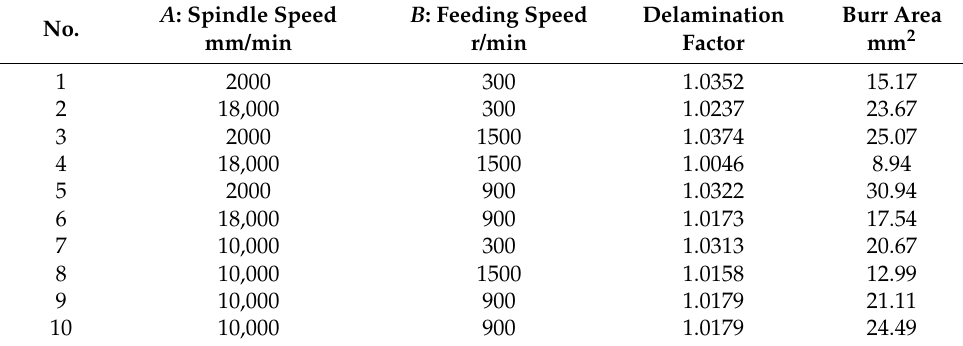
Table 3. Design and test results of response surface method.